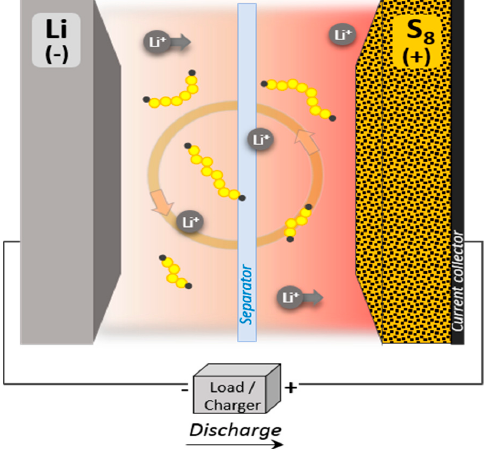
Figure 1. Schematic showing the operation of a Li-S cell during discharge.